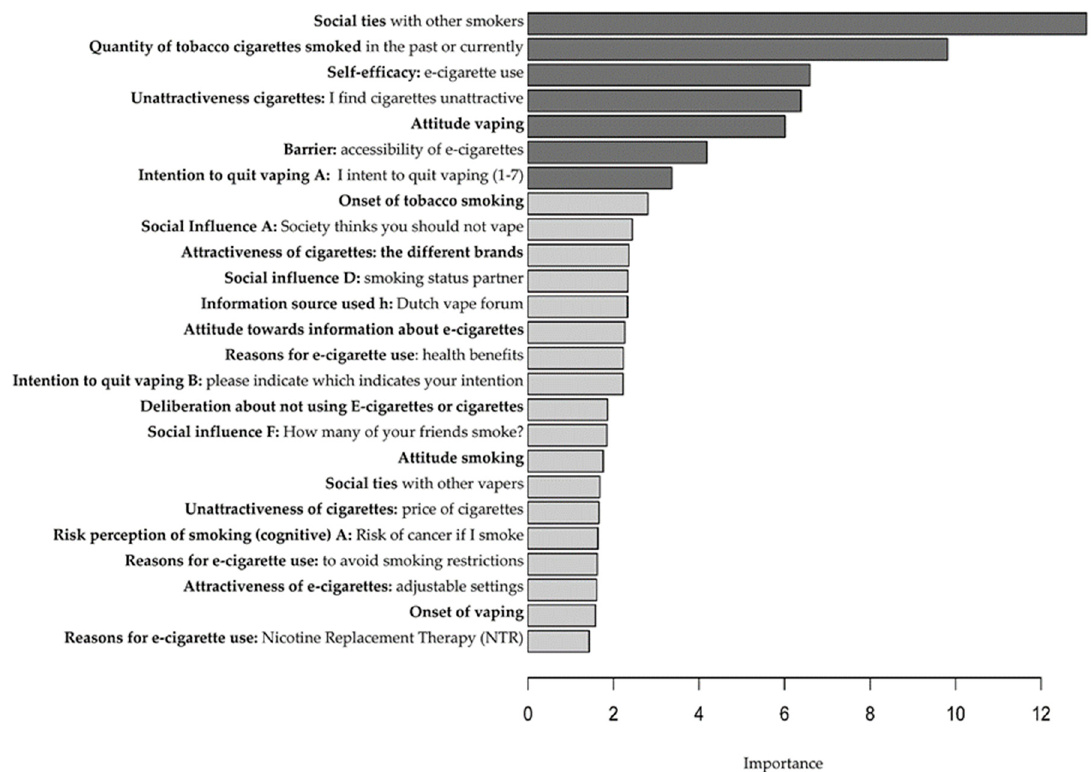
Figure 1. Top twenty-five factors to distinguish between dual users and e-cigarette users. Bar lengths indicate the variable importance factors, the seven significant (FDR 5%) factors are shown in dark gray.